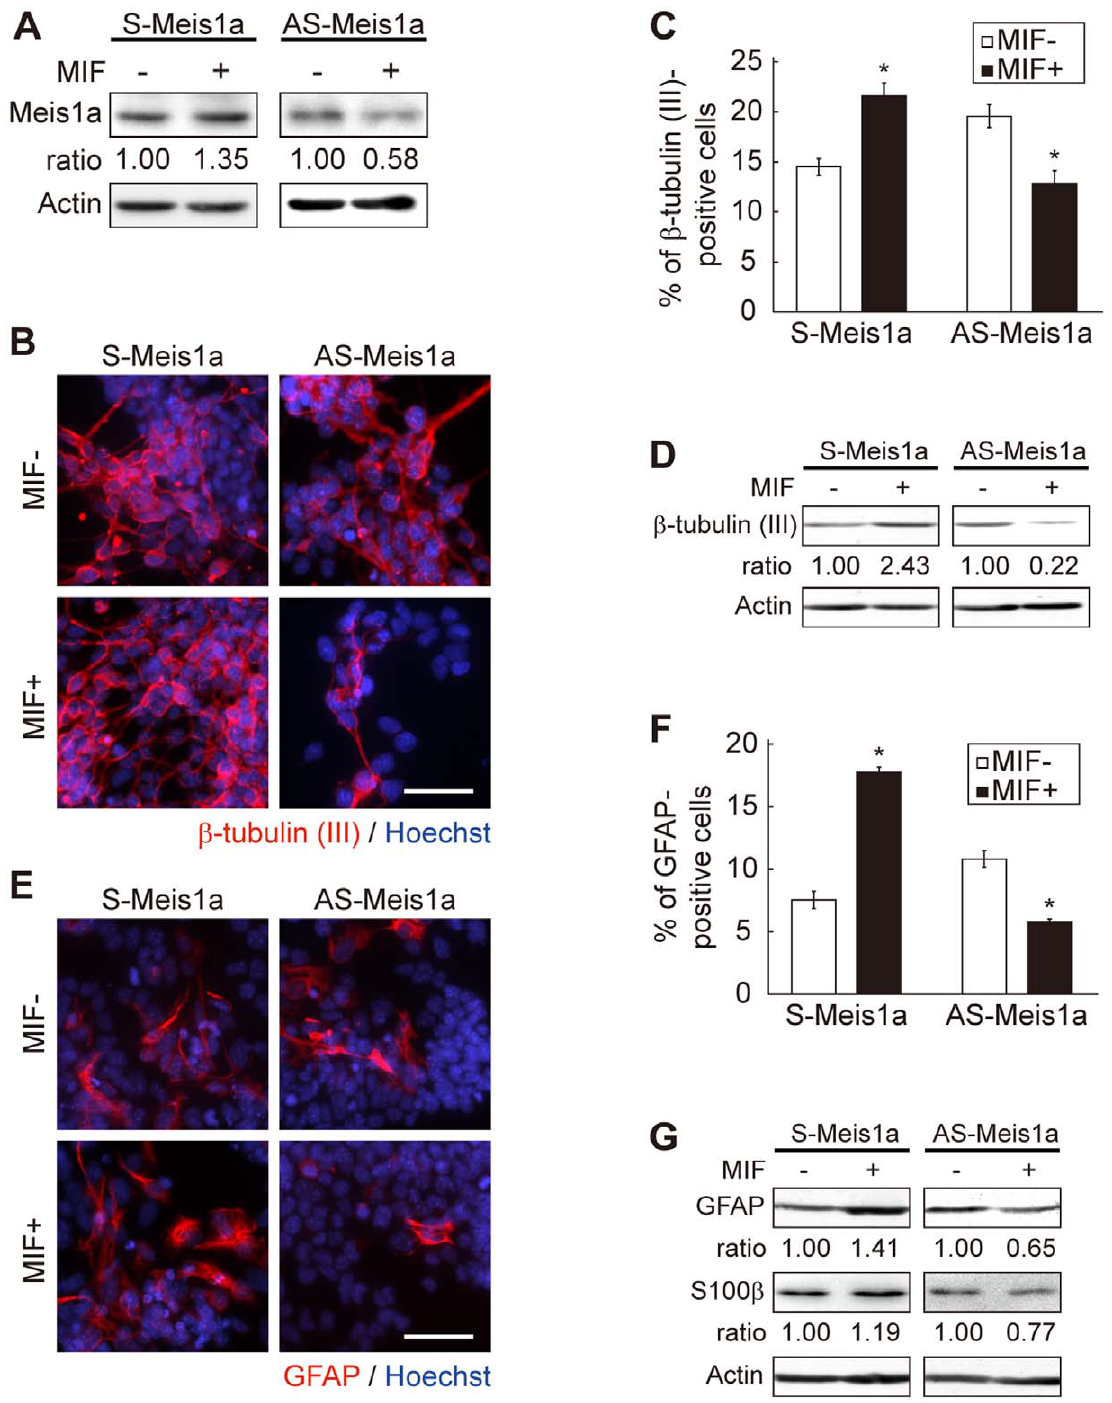
Figure 2. Involvement of Meis1a in neural differentiation of RA-primed P19 cells. ( A ) Expression levels of Meis1a in S-Meis1a and AS- Meis1a cells with or without MIF. ( B ) Functional analysis of Meis1a in neuronal differentiation. Aggregated S-Meis1a and AS-Meis1a cells were treated with RA in the presence or absence of MIF for 4 days, additionally cultured in RA-free medium for 3 days, and stained with anti- b -tubulin (III) antibody, followed by Cy3-conjugated anti-mouse IgG antibody. Nuclei were stained with Hoechst 33258. Scale bar =100 m m. ( C ) Quantification of the effect of Meis1a on neuronal differentiation indicated in B . ( D ) Effect of Meis1a on b -tubulin (III) expression. Differentiated S-Meis1a and AS-Meis1a cells with or without MIF were lysed and analyzed by WB with anti- b -tubulin (III) antibody. ( E ) Effect of Meis1a on GFAP-positive astrocyte differentiation. RA- treated S-Meis1a and AS-Meis1a cells were additionally cultured for 7 days and then stained with anti-GFAP antibody. ( F ) Quantification of the effects of Meis1a on astrocyte differentiation indicated in E . ( G ) Effect of Meis1a on GFAP and S100 b expressions. Differentiated S-Meis1a and AS-Meis1a cells with or without MIF were analyzed by WB with the anti-GFAP and anti-S100 b antibodies. * p , 0.005 significantly different from MIF( 2 ) control cells. n= 3.